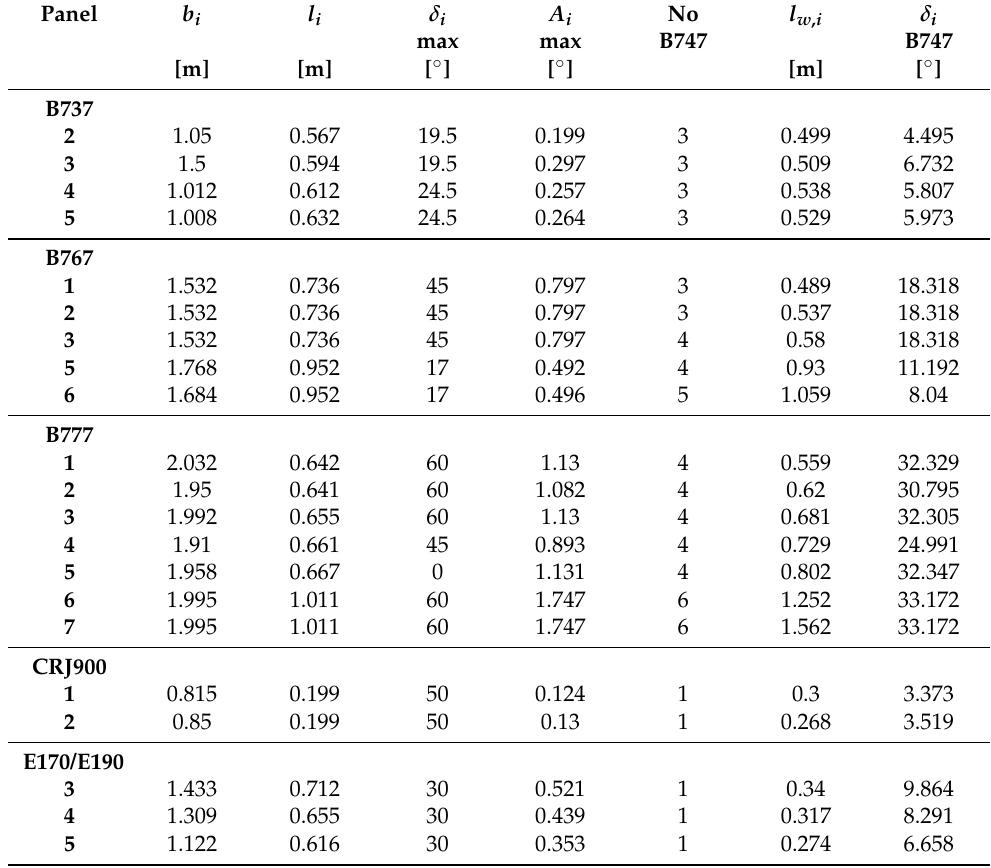
Table 3. Transfer of aircraft-specific speed brakes and their mean wing depth l w , i to the speed brakes of B747 (No, B747) parameterized by NASA (numbered from outside to inside). Additionally, individual aircraft speed brake length l i , width b i , area A i , maximum speed brake angles δ i , max , and the resulting maximum speed brake angles of the corresponding B747 speed brake δ i [ ◦ ] are